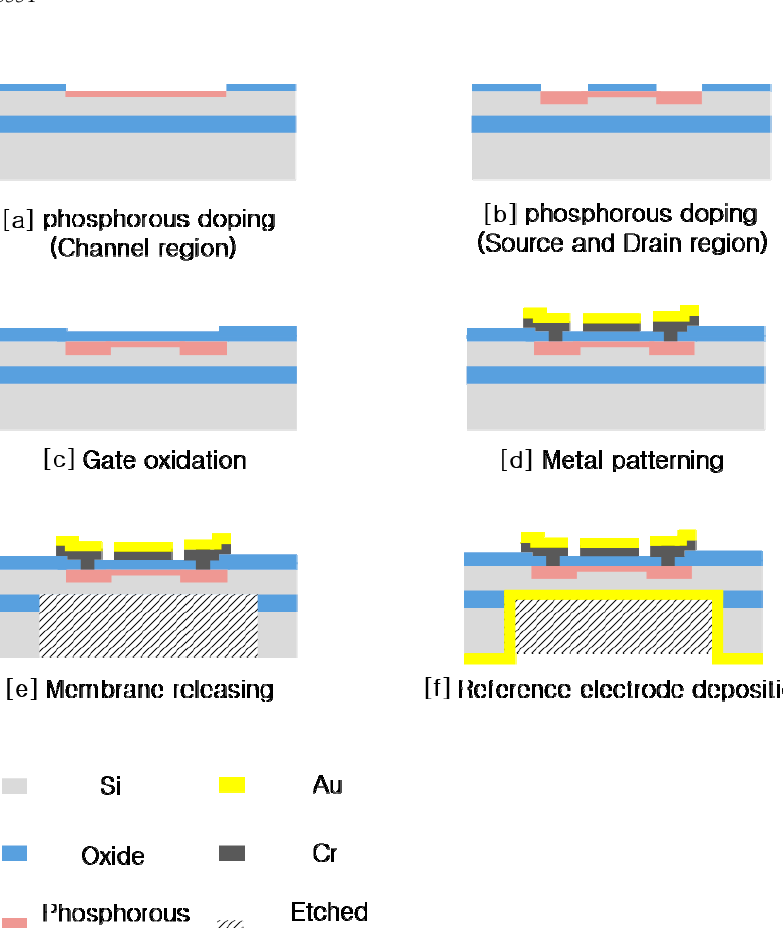
Figure 7. Fabrication process: FET embedded diaphragm substrate.